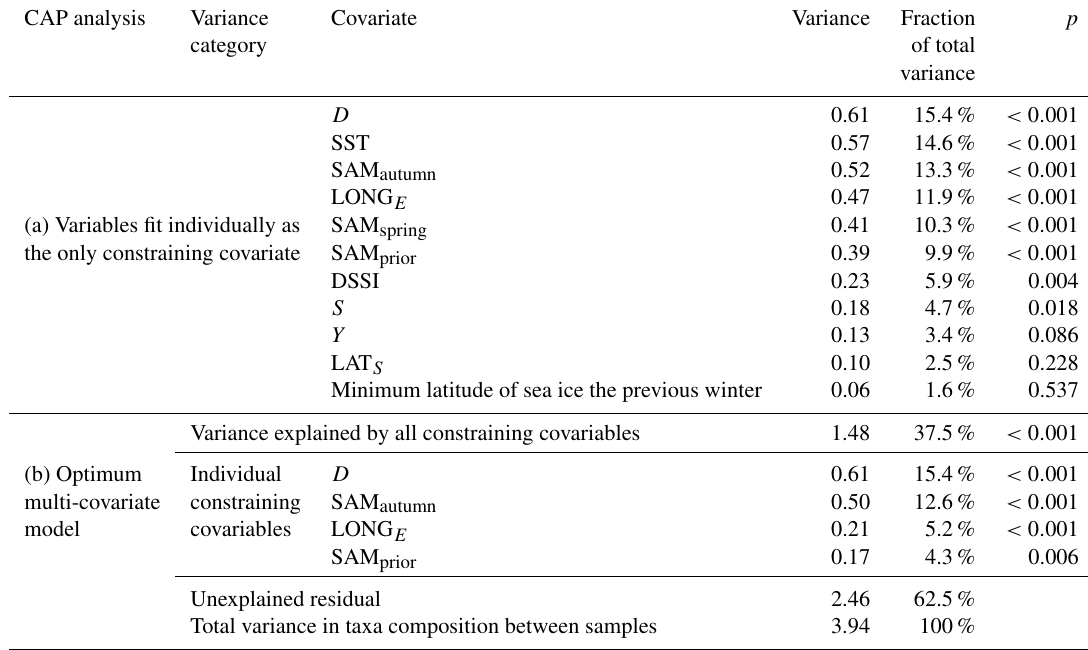
Table 1. Variance in the community composition of 22 phytoplankton taxa groups attributable to constraining environmental covariables in the CAP